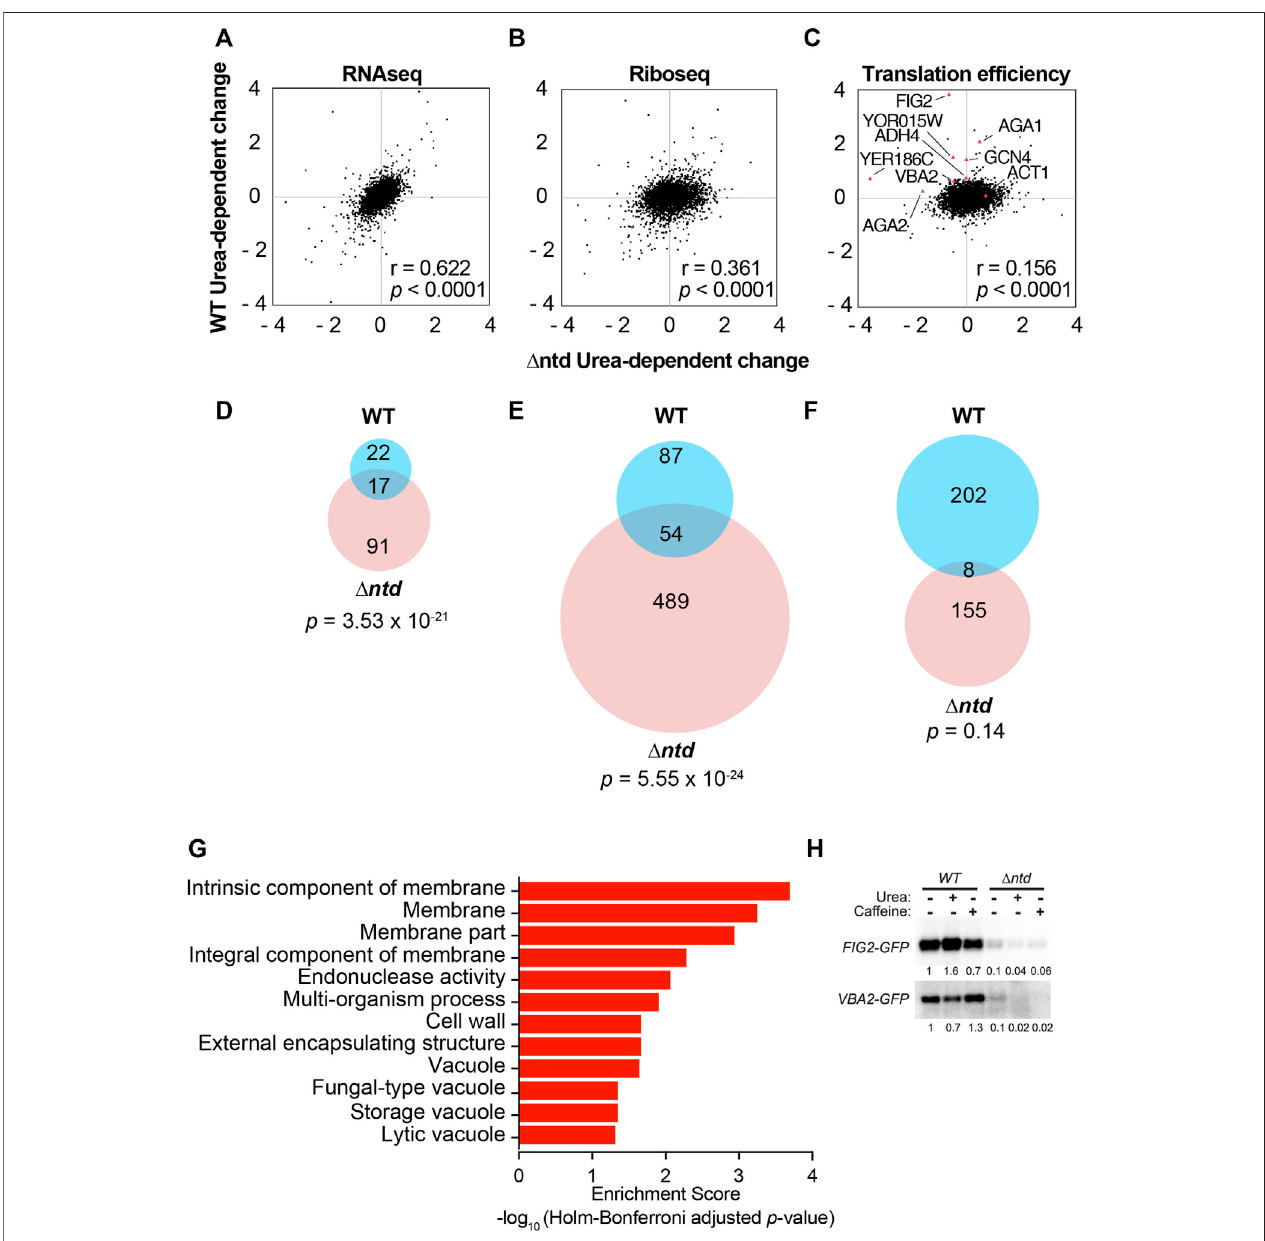
FIGURE3| TheNTDofeIF4BpromotestranslationofmRNAsencodingproteinsassociatedwiththemembraneandcellwall. (A – C) ComparisonofLog 2 valuesfor changes in RNAseq (A) , Riboseq (B) , or TE (C , Translation ef fi ciency) in response to 3% urea for WT are plotted vs. the Log 2 values for changes observed in the NTD deletionmutantforeachofthe4070geneswithmeasurableexpressionineachgroup.NinemRNAsareindicatedin (C) ,whichwereanalyzed byqRT-PCRofpolysome gradientfractions in SupplementaryFigure S3 Pearson correlation coef fi cients are shown. (D – F) Overlap ofurea-dependent genes exhibiting1.5-foldor greater increase in RNAseq (D) , Riboseq (E) , or TE (F) for WT and Δ ntd . The Fisher ’ s exact p -values were shown to indicate the statistical signi fi cance of overlap between two datasets. (G) Gene ontology analysis for urea-dependent RNAs (e.g. increased TE in WT in response to urea.) (H) . Western analysis of GFP translation reporters. The 5 ′ UTR and fi rst 30 nucleotides of the FIG2 and VBA2 genes were fused to GFP in a plasmid under the native promoters for each. Indicated transformants of WT and Δ ntd eIF4B-expressing yeast were subjected to anti-GFP western analysis following growth in the absence or presence of 3% urea or 1.5 mg/ml caffeine. The fractions of reporter band intensity per total protein bands for each lane on the gel were normalized to WT eIF4B without additive for each reporter.